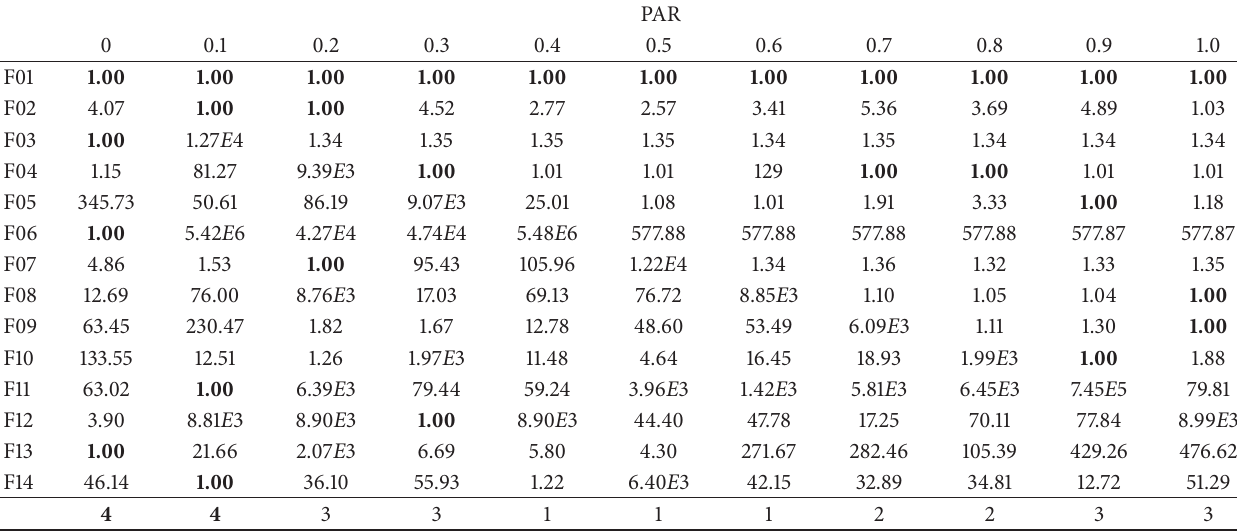
Table 12: Mean normalized optimization results in fourteen benchmark functions with different PAR. The numbers shown are the best results found after 100 Monte Carlo simulations of HS/BA